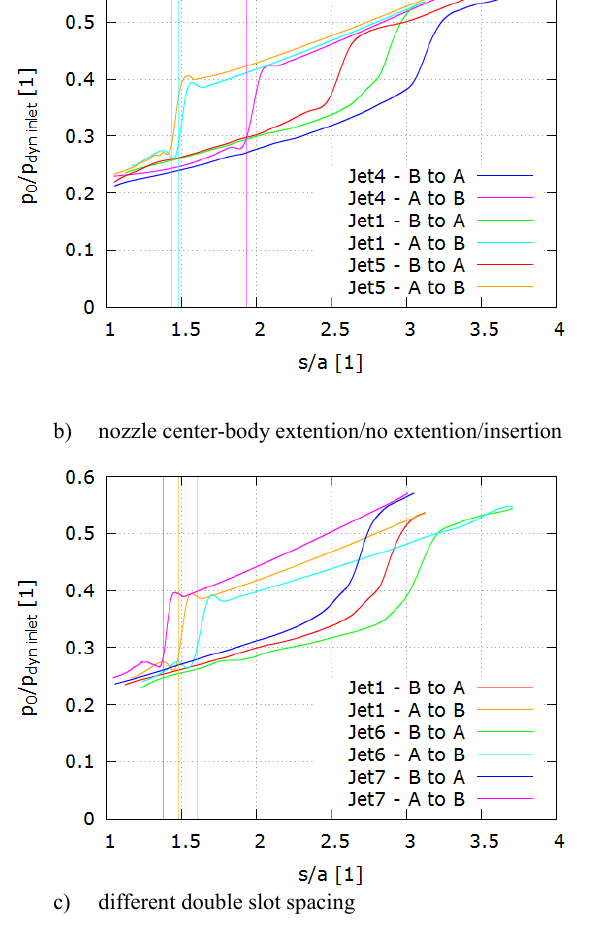
Fig. 3. Hysteresis loops of central stagnation pressure at the intersection of jet axis with target surface Figure 3 shows stagnation pressure at the intersection of jet axis with target surface and provides a nice hysteresis loops for all investigated